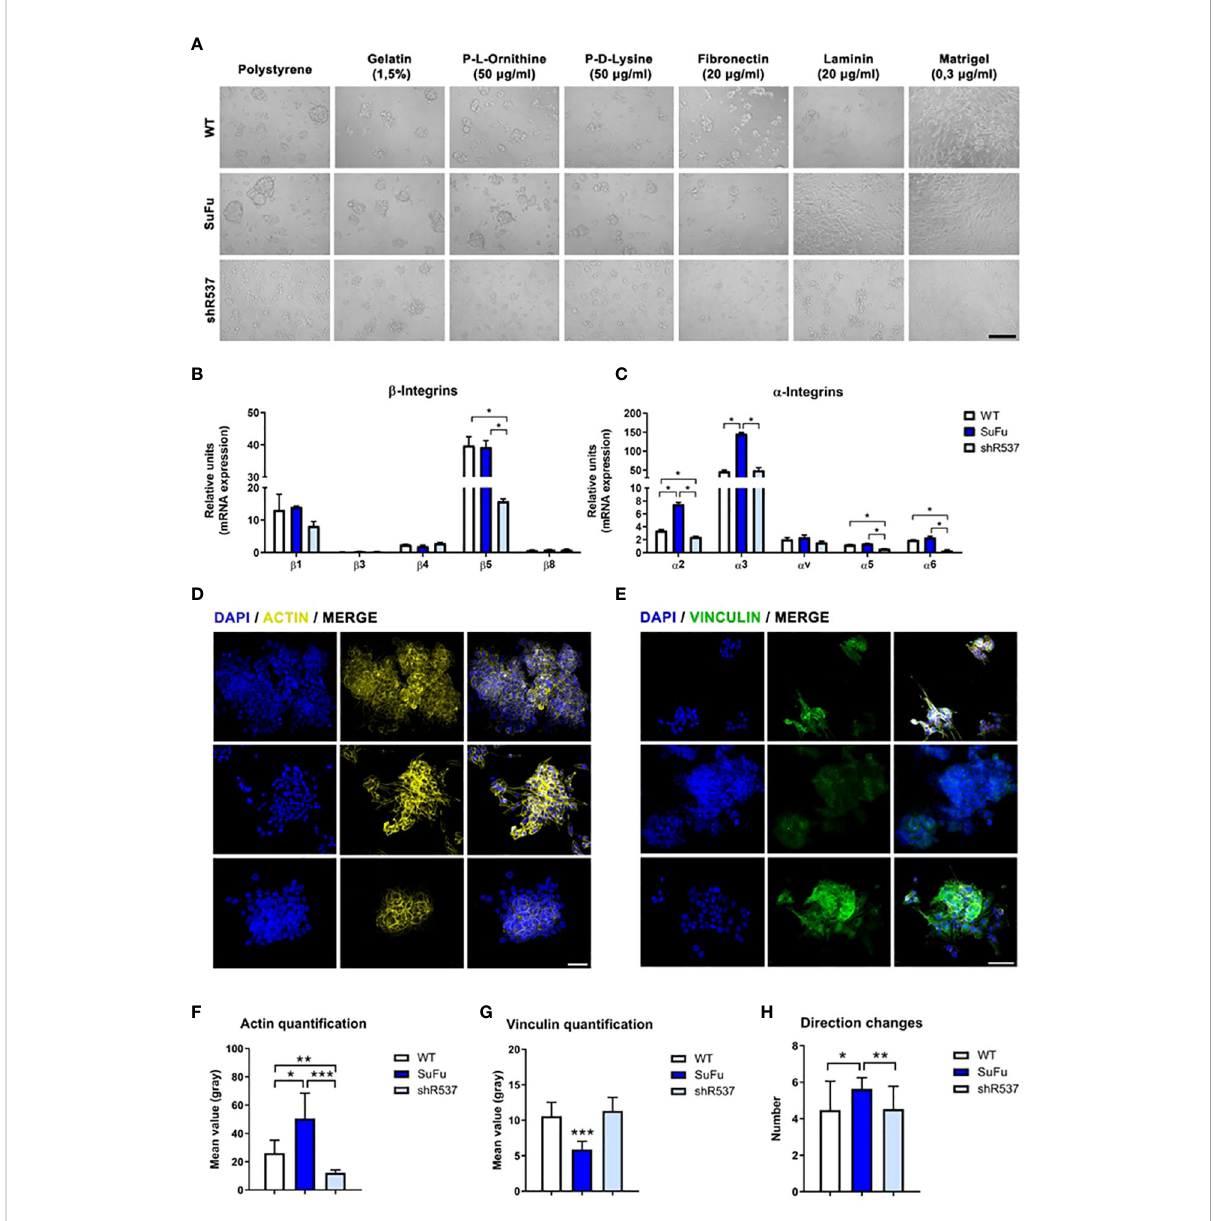
FIGURE 3 (A) Cell adhesion assay in vitro . (B) b -integrin subunits expression in GB18 CSCs. (C) a -integrin subunits expression in GB18 CSCs. (D) Representative image of actin immuno fl uorescence staining. (E) Immuno fl uorescence staining of vinculin. Scale bar represents 50 µm.